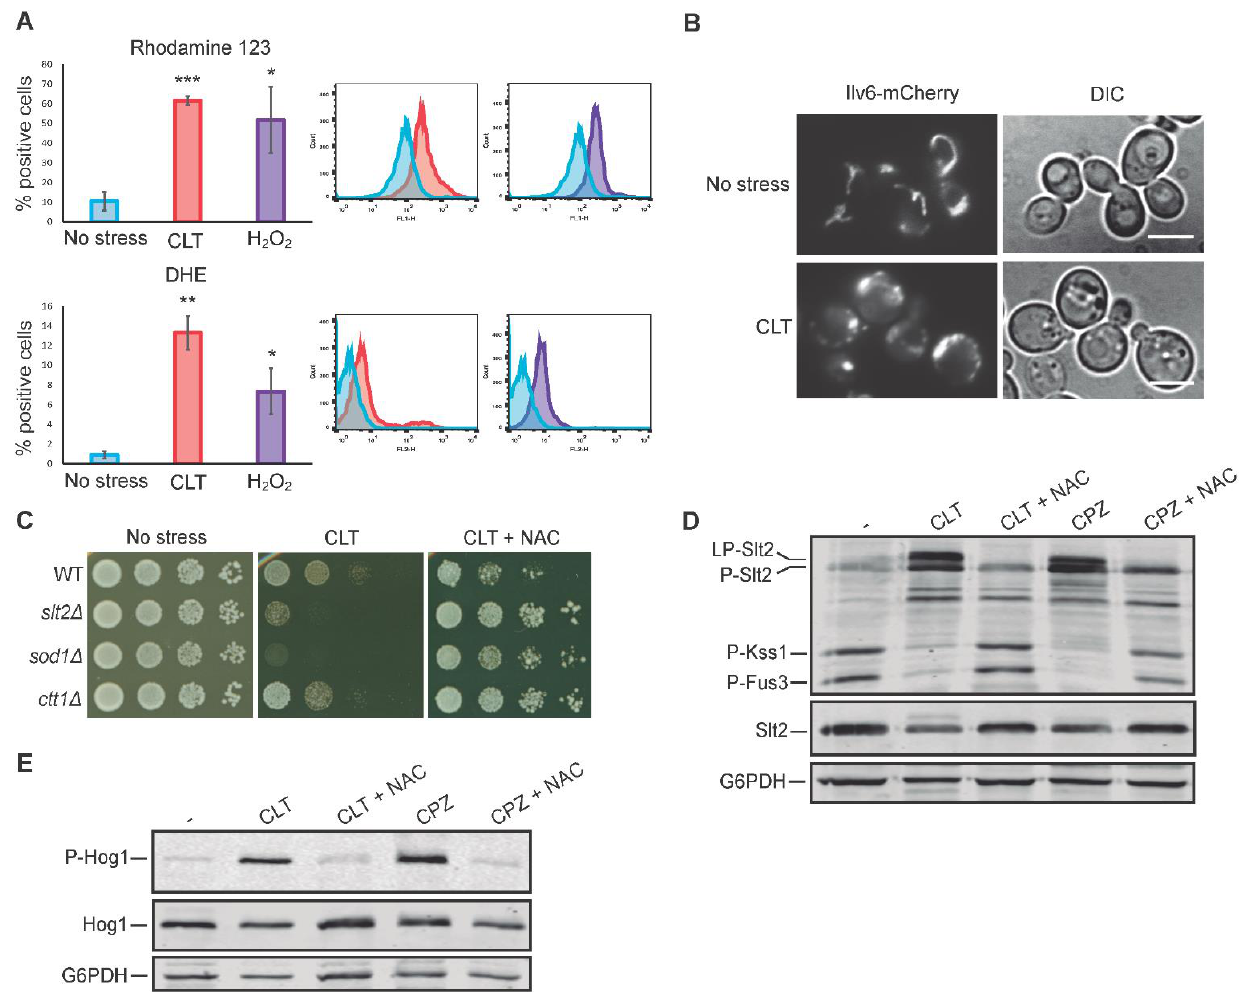
Figure 6. Effect of clotrimazole on mitochondrial morphology and oxidative stress: impact on MAPK phosphorylation. ( A ) Flow cytometry assay of the BY4741 strain after treatment with 50 µg/mL of CLT, 10 mM of H 2 O 2 , or basal conditions (no stress) for 4 h. Graphs represent the percentage of positive cells detected with flow cytometry that express a fluorescence signal for rhodamine 123 or dihydroethidium (DHE) fluorochromes. Data are presented as the mean of three independent experiments, and error bars indicate the standard deviation. Histograms from a representative experiment are shown. Student’s t-test was calculated between treated (CLT or H 2 O 2 ) and non-treated (no stress) cells. p -value of < 0.05 (*), < 0.01 (**), or < 0.001(***). ( B ) Mitochondrial morphology alteration upon CLT treatment. Fluorescence and DIC microscopy images of BY4741-T cells transformed with YEplac112-Ilv6-mCherry plasmid after treatment with 50 µg/mL of CLT or in basal conditions (no stress) for 4 h. Representative photographs from two independent experiments are shown. Scale bar = 5 µm. ( C ) Sensitivity of BY4741 (WT) and the indicated isogenic mutant strains to CLT per a drop dilution growth assay. Ten-fold serial dilutions of cell suspensions were spotted onto YPD plates in the absence (no stress) or presence of 1 µg/mL of CLT and incubated at 30 °C for 72 h. Plates were supplemented with 20 mM of N-acetylcysteine (NAC) when indicated. A representative assay from three independent experiments is shown. ( D , E ) Western blotting analysis of the extracts of BY4741 cells treated with 50 µg/mL of CLT or 250 µM of chlorpromazine (CPZ) in combination with 20 mM of NAC, when indicated. Cells were cultured for 4 h ( D ) or 30 min ( E ) at 24 °C. Dually phosphorylated Slt2, Kss1, and Fus3; Slt2 protein; dually phosphorylated Hog1; Hog1 protein; and G6PDH (as a loading control) were detected with anti-phospho-p44/42, anti-Mpk1, anti-phospho-p38, anti-Hog1, and anti-G6PDH, respectively. Representative blots from three ( D ) and two ( E ) independent experiments are shown.